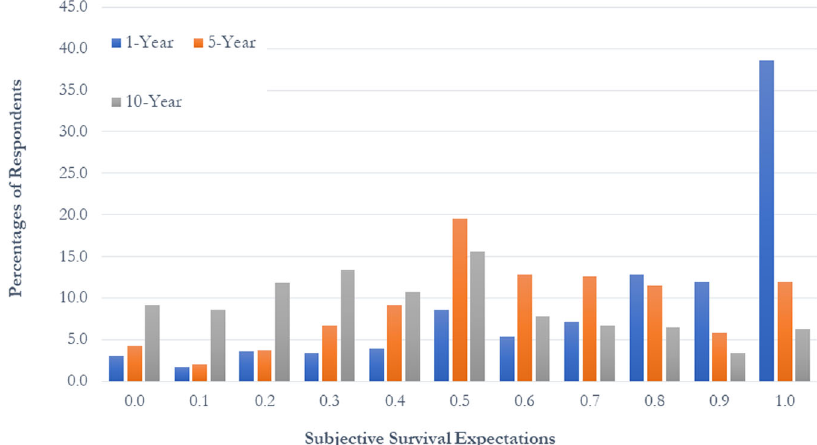
Fig. 3 Proportion of respondents by SLE. Percentage distribution of older adults by their subjective probability of own survival (weighted) for one, fi ve and ten years, LASI, 2017 –